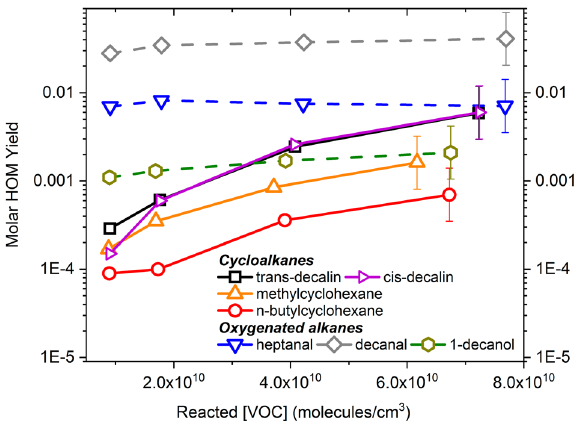
Fig. 3 Molar HOM yields at 300K as a function of reacted VOC, measured in the Helsinki fl ow reactor at a residence time of 3 s. The error bars, included only for the last point of each trace, show the uncertainty of the HOM measurement. No multi-generation OH oxidation takes place due to the high VOC concentration (10 ppm) and the short residence time. Linear alkanes did not produce observable HOM signals under these